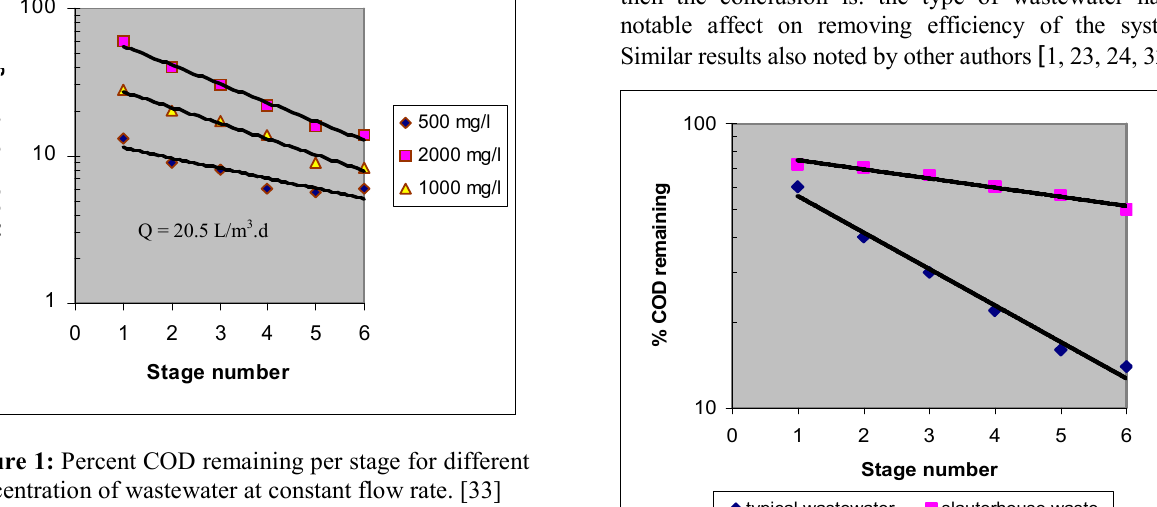
Figure 3: Percent COD remaining per stage at a constant flow rate, concentration and, rotation velocity. [33]